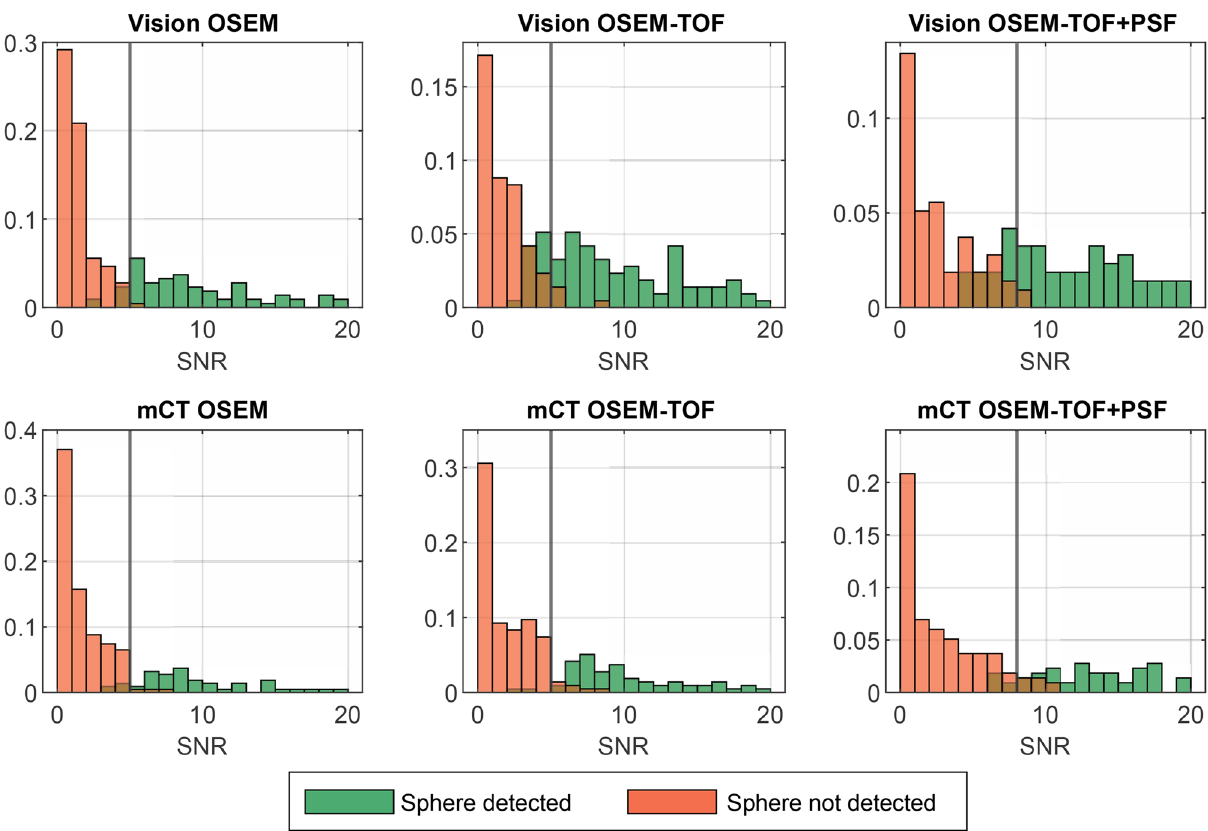
image reconstruction, respectively, indicate the threshold that was derived to define a lesion as detectable in the mathematical model. For clarity purposes, SNR values > 20 are not displayed. The mixed organge- brown color arises from superposition of orange and